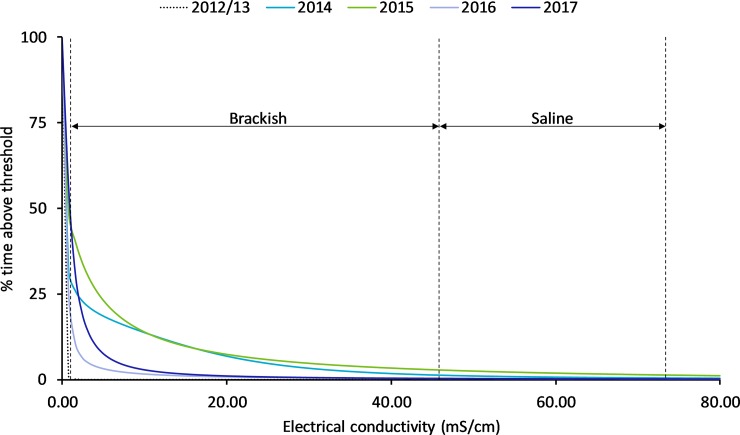
The percentage of time EC exceeded any given EC threshold during pre and post bund removal years within the Boolgooroo wetland.Horizontal dashed lines show boundaries between fresh, brackish, saline and briny water from left to right.